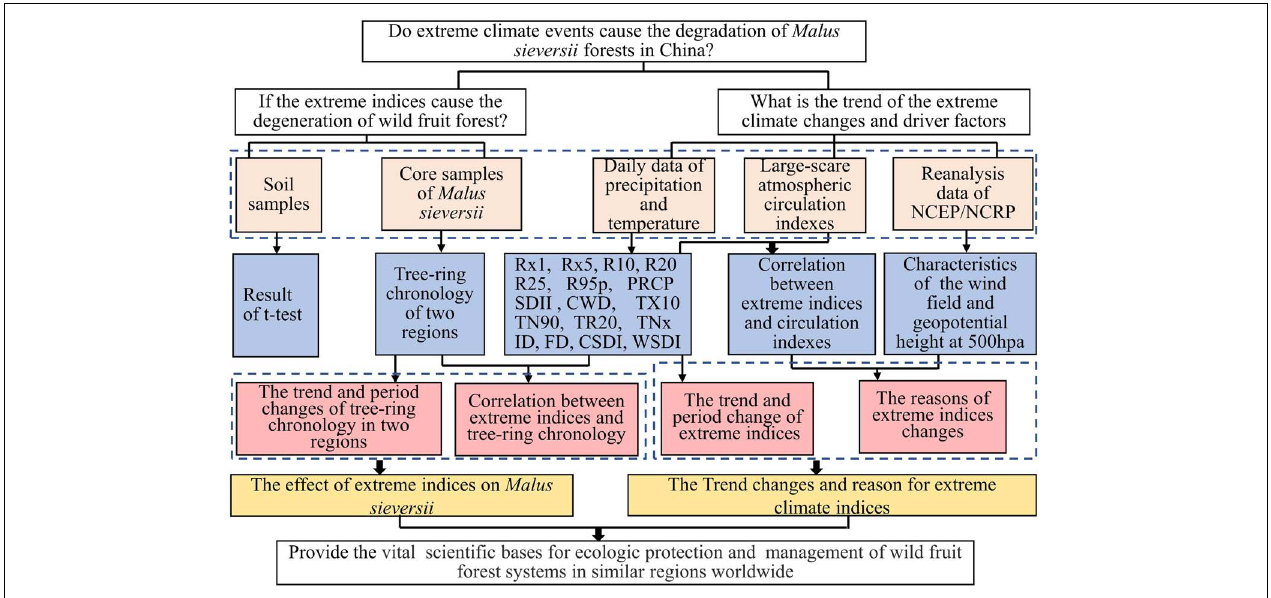
FIGURE 2 | Flow chart of the